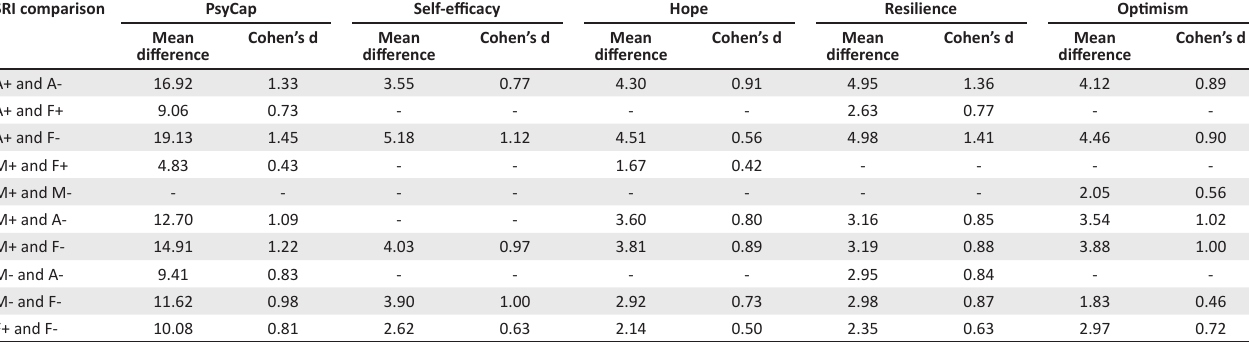
TABLE 5: Tukey’s post-hoc tests: SRI, PsyCap, self-efficacy, hope, resilience and optimism. SRI